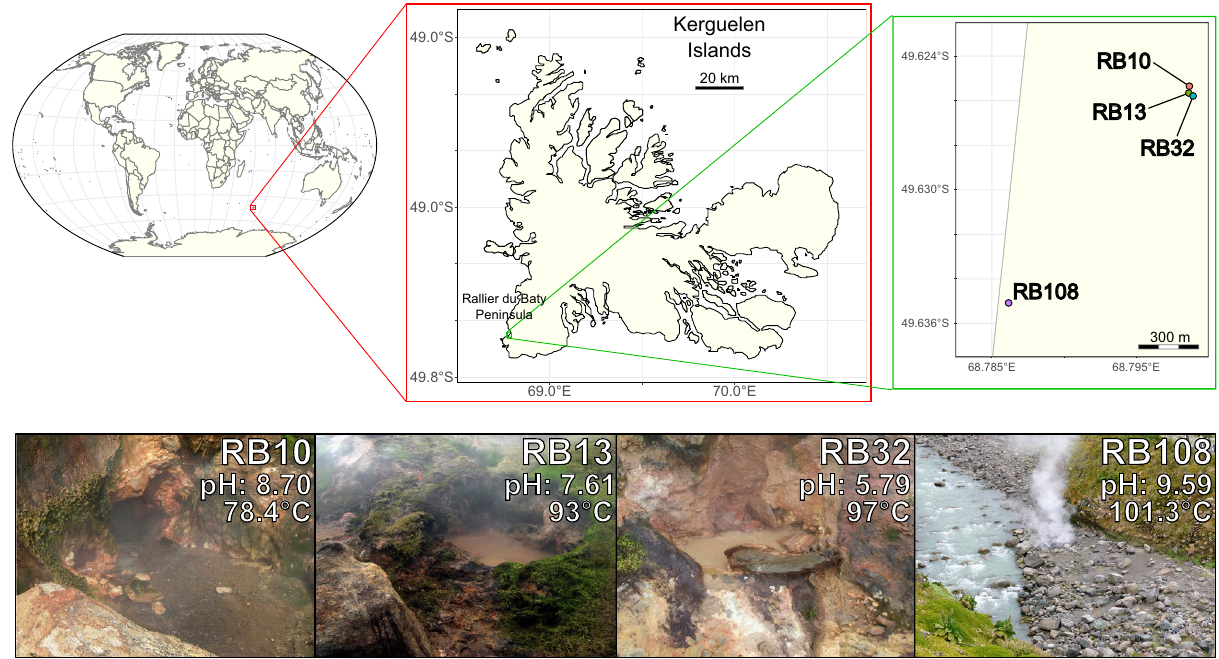
Figure 1. Sampling locations at the plateau des Fumerolles in the Rallier du Baty Peninsula (Kerguelen Islands, French Southern and Antarctic Lands), and photographs of the four hot springs studied here with their associated temperature and pH conditions. The world map and details of the Kerguelen seashore were generated using the ‘cowplot’, ‘ggplot2’, ‘lwgeom’, ‘rnaturalearth’, ‘rnaturalearthdata’, ‘rworldmap’, ‘sf’ and ‘tidyverse’ libraries implemented on the RStudio software (v1.2.5001). A 2018 map of the Kerguelen islands was retrieved from the French national portal of maritime limits (http:// limit esmar itimes. gouv. fr/) according to the 2017 Etalab open license (v2.0—https:// www. etalab. gouv. fr/). Pictures depicting sampling sites were taken by Marc Le Romancer. Layout was carried out using the free open source vector image editor Inkscape